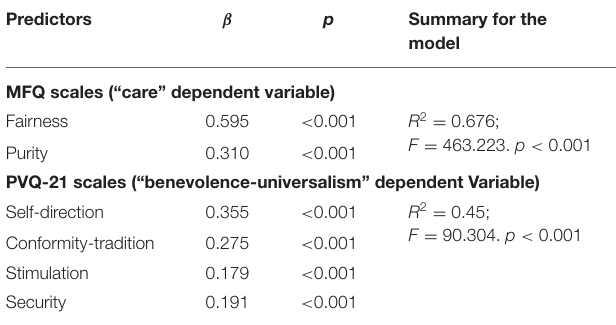
TABLE 3 | Comparison of Russians in terms of moral norms (MFQ) and value indices (PVQ-21), taking into account volunteer experience. Indicators